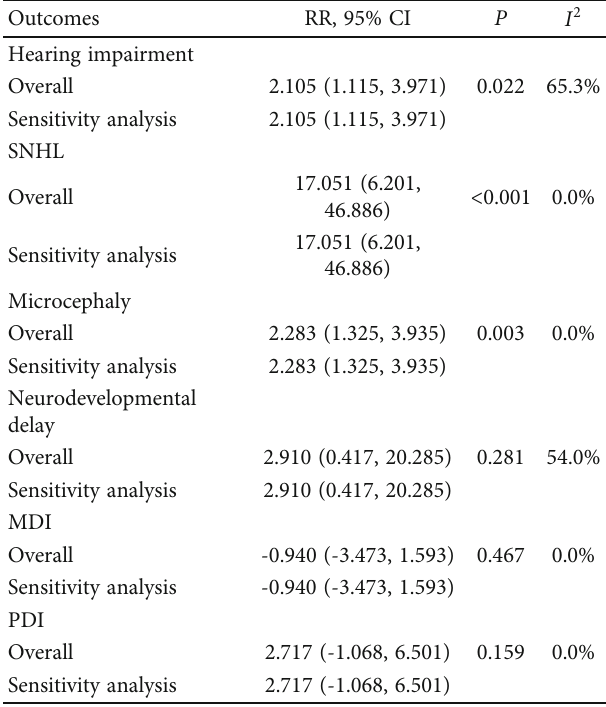
Table 2: Overall results and sensitivity analysis.